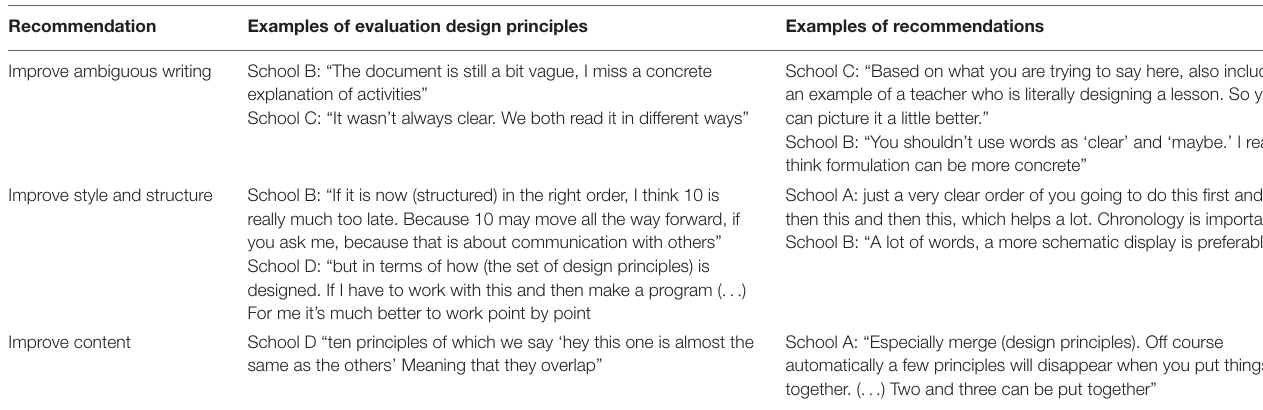
TABLE 6 | Different types of recommendations with examples from the group